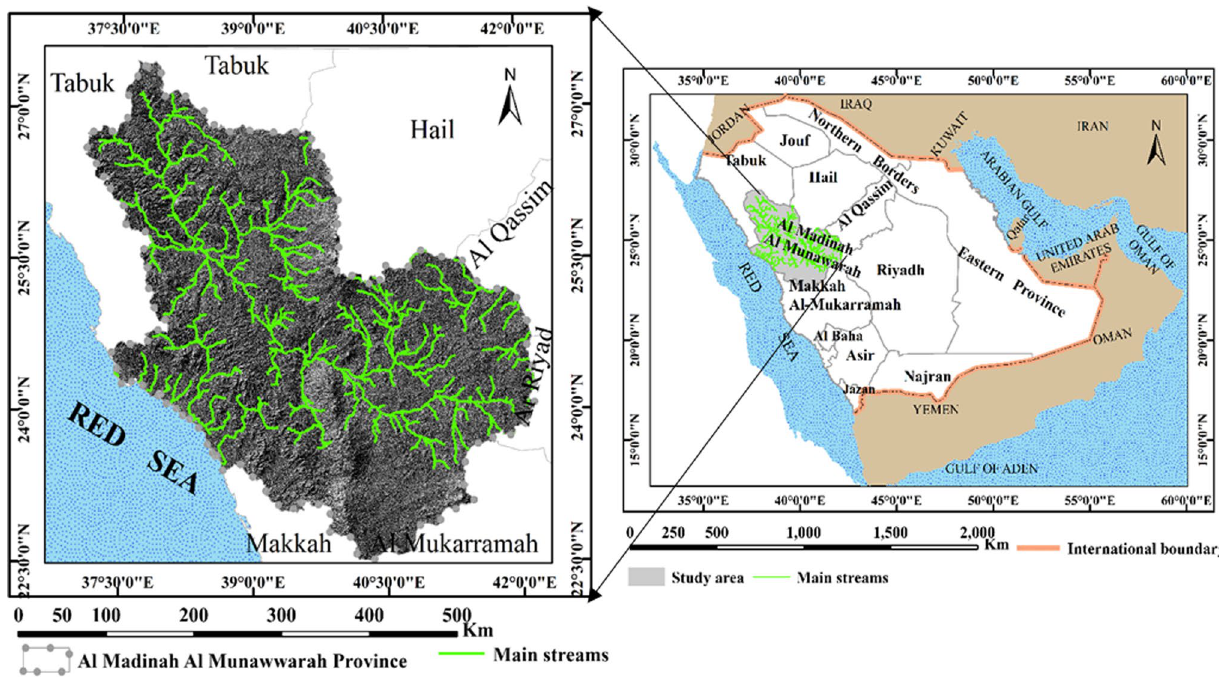
Fig. 1 Location map of Al-Madinah Al-Munawarah Province